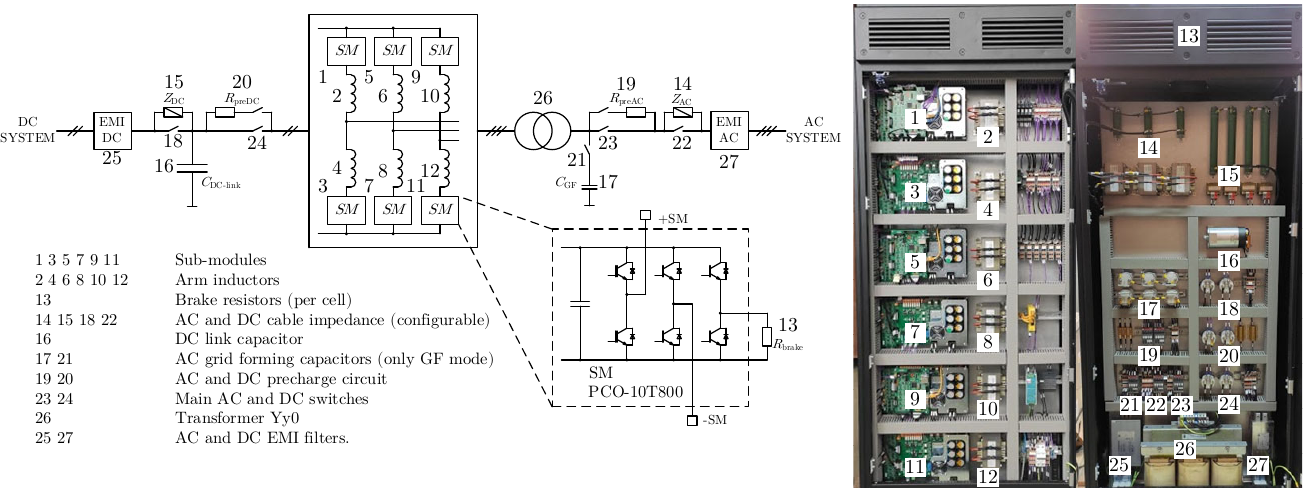
Figure 4. Single-line diagram of the converter and image of the assembled system. Front view ( left ) and rear view ( right ).